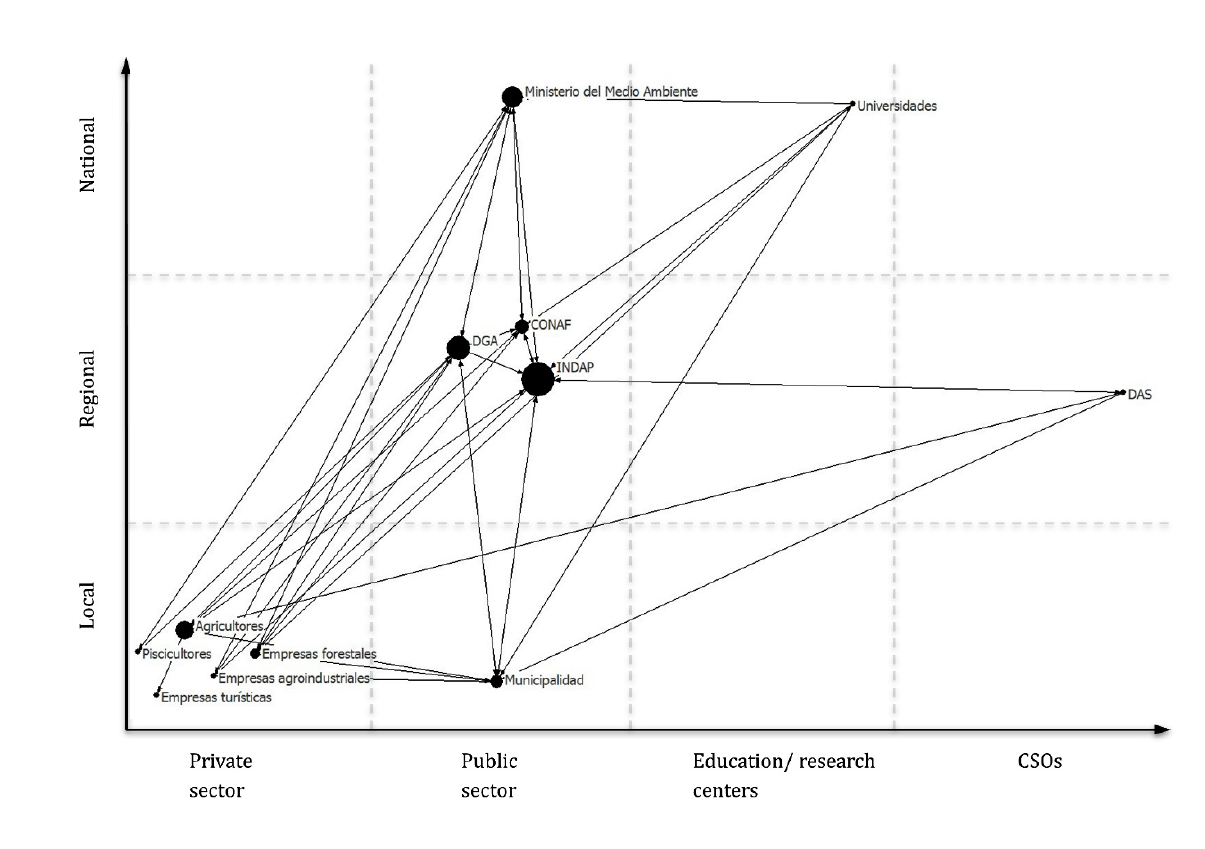
Fig. A2.2. Water governance network from the perspective of representatives of public entities in the Araucarias del Alto Malleco Model Forest (AAMMF), Chile. The actor nodes in the networks represent organizations and social groups perceived as relevant to water resources management. The x-­‐axis categorizes the actor nodes according to the sector they relate to. Civil society organizations (CSOs) include non-­‐governmental organizations. The y-­‐axis categorizes actor nodes by their scale of action. The local scale relates to the pilot area in the AAMMF, the regional scale corresponds to the model forest landscape, and the national scale represents Chile. Actor node size relates to inbetweenness centrality, which corresponds to the importance of the node as bridge in the network. See Appendix 3 for a list of the main actors and the role they play in the water governance network according to participants’